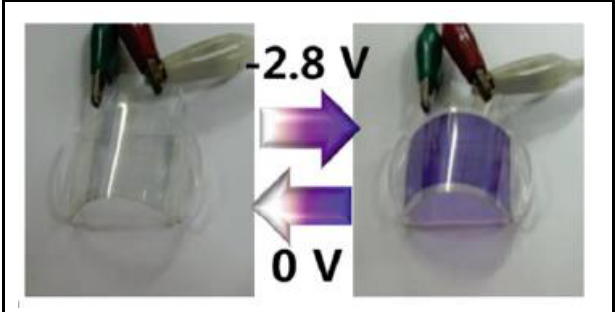
Figure 4. Photographs of reversible performance of a flexible methyl viologen (MV 2+ ) graphene quantum dot (GQD) bent ECD with ITO-on-PET in bleached (left) and colored (right) state (−2.8 V). Reprinted with permission from [140], copyright (2014) John Wiley and Sons, Inc.